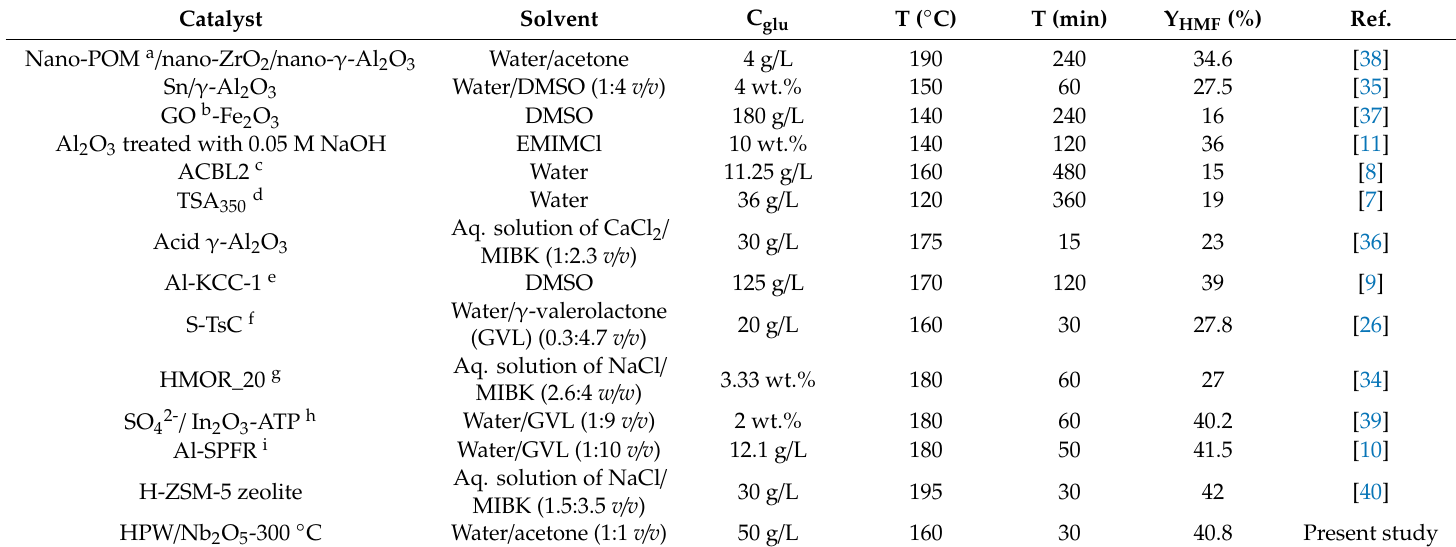
Table 6. Comparison of the performance of HPW / Nb 2 O 5 -300 ◦ C catalyst with some recent works reported in literature on HMF production from glucose.